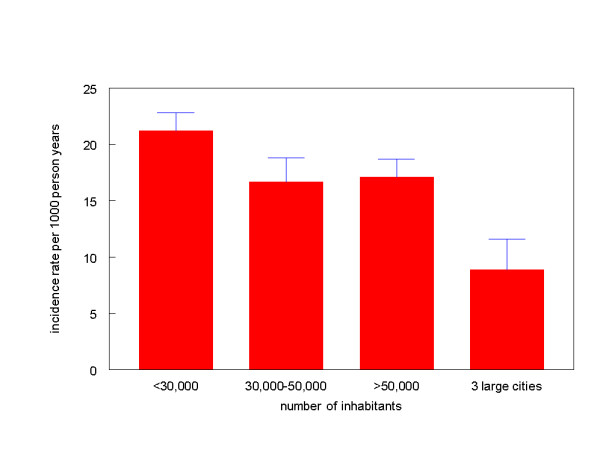
Incidence rates according to urbanisation, 95% error bars.